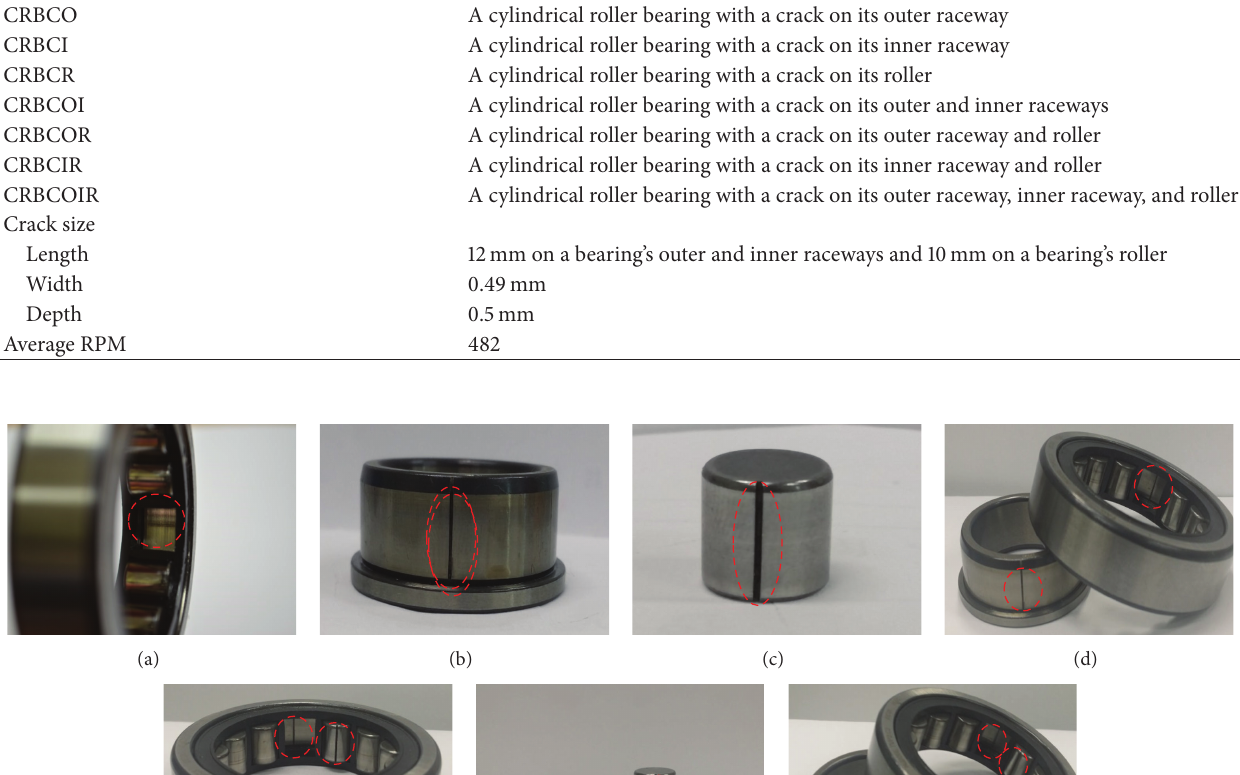
Table 2: Seeded bearing failures considered in this study.